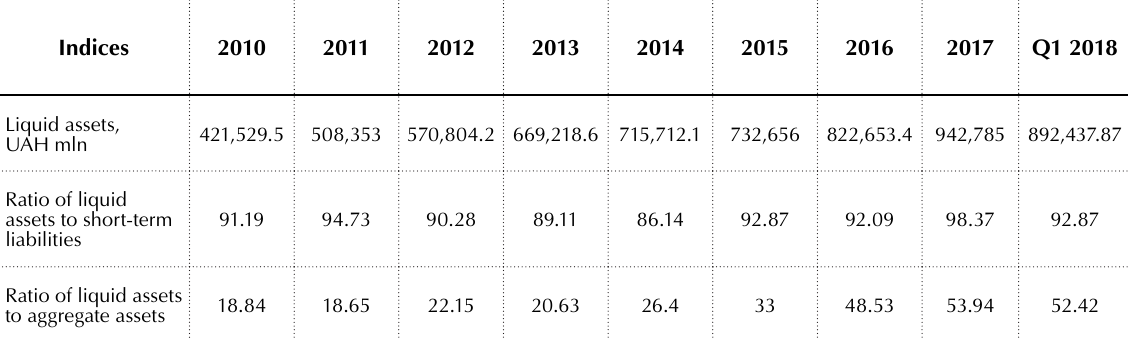
Table 3. Liquid assets and key indicators of financial sustainability of Ukrainian banks